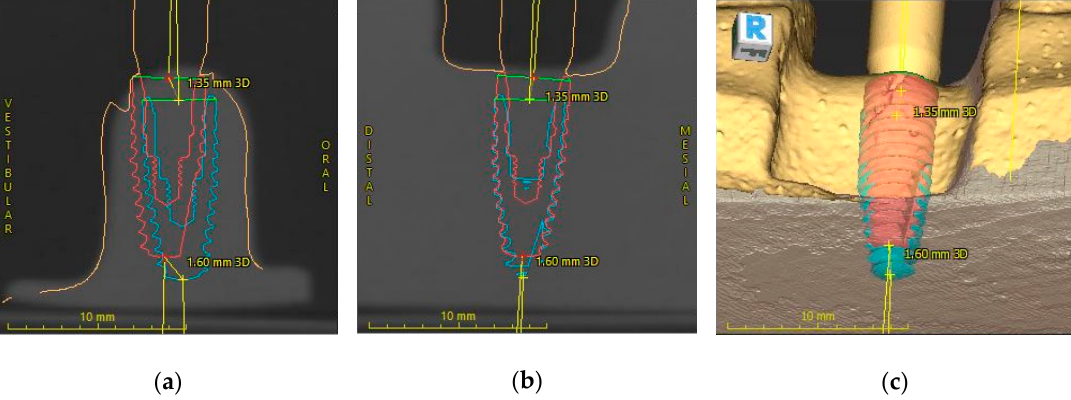
Figure 4. The 3D measurement of implant deviation in coDiagnostiX ™ software. Post-operative implant position (blue) merged with pre-operative implant position (red); ( a ) Cross-sectional; ( b ) Tangential view; ( c ) 3D view.